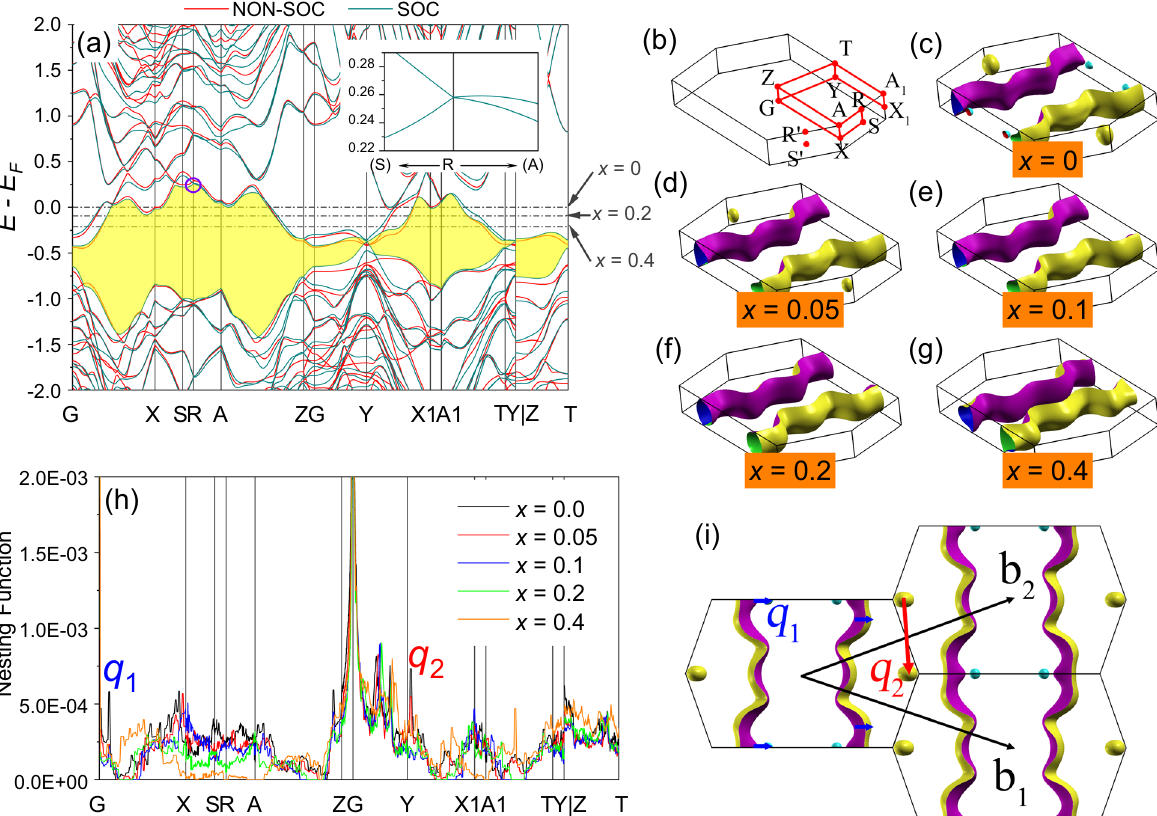
Fig. 6 Calculated electronic structure and Fermi-surface nesting functions of Re 3 Ge 7 − x Ga x . a Bulk band structure for Re 3 Ge 7 − x Ga x without and with SOC. The yellow shaded region corresponds to the band fi lling of x = 1. b Brillouin zone of Re 3 Ge 7 − x Ga x with high-symmetry points and lines. c – g The Fermi-surface for Re 3 Ge 7 − x Ga x with x = 0, 0.05, 0.1, 0.2, and 0.4, respectively. h The calculated Fermi-surface nesting functions at high-symmetry lines. i A diagrammatic sketch of nesting vectors q 1 and q 2